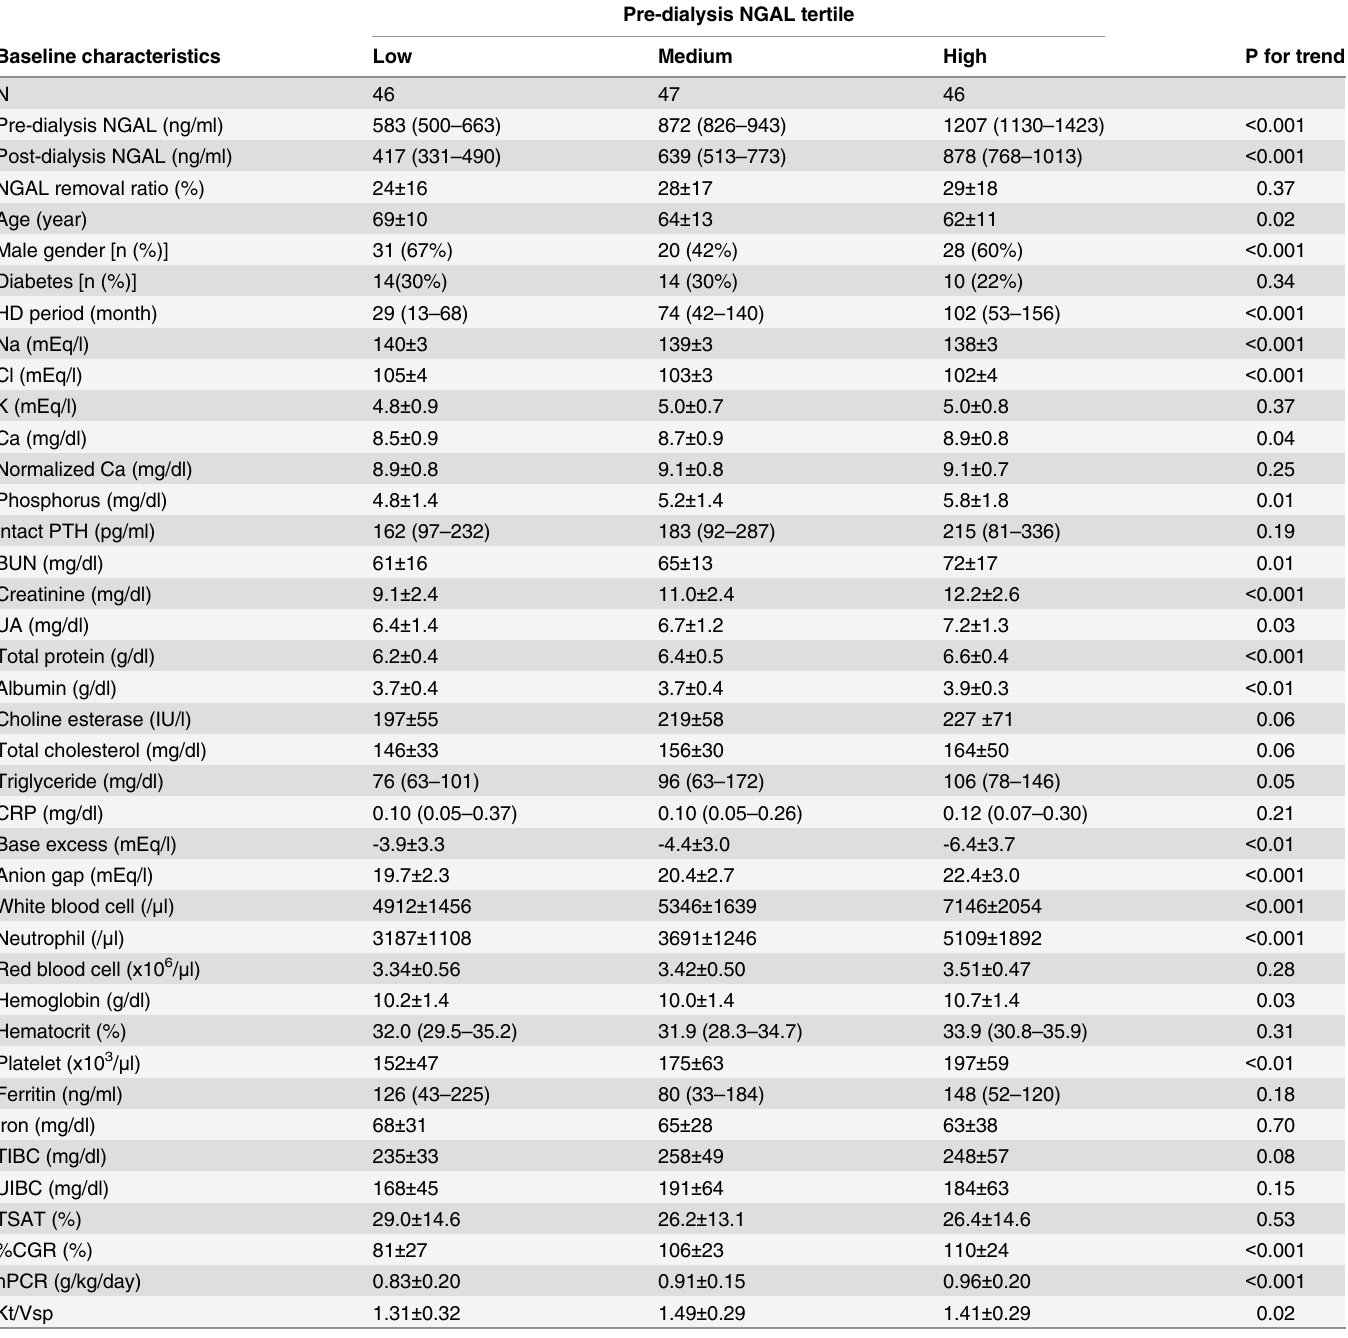
Table 1. Baseline characteristics of 139 maintenance HD patients in correlation with tertiles of serum NGAL